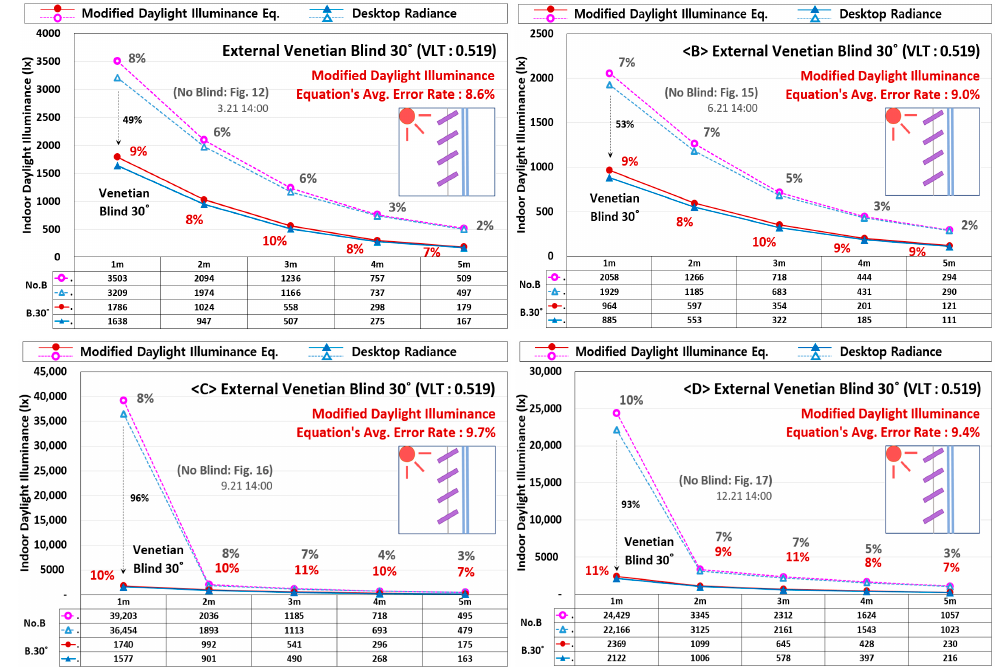
Figure 20. Comparison of indoor illuminance between the modified equation and Desktop Radiance simulation when installing external venetian blind 30° ( A ) 3.21 ( B ) 6.21 ( C ) 9.21 ( D ) 12.21 (14:00).